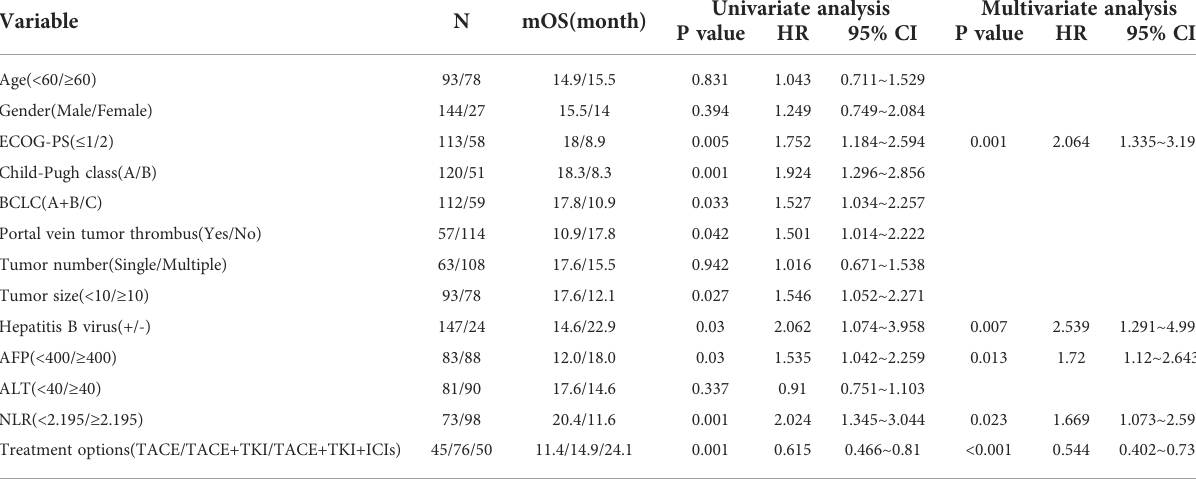
TABLE 4 Analysis of OS prognostic factors in unresectable HCC patients.